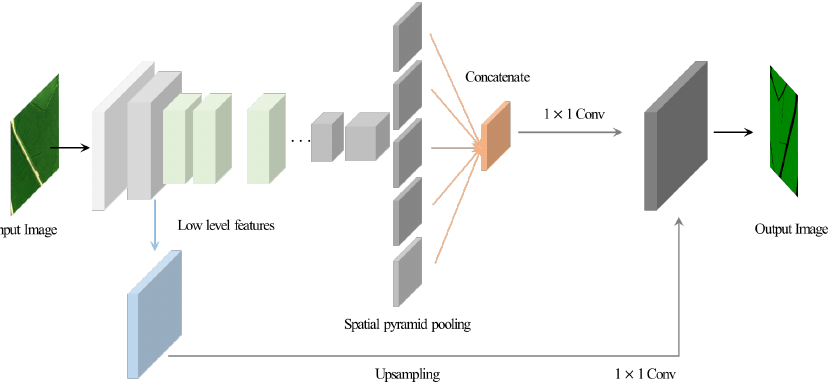
Figure 5. The DeepLab V3+ structure for detecting cabbage fields. Although there are differences in the sizes of cabbage field, an atrous convolution in the encoder can accommodate the differences and extracts multi-scale context